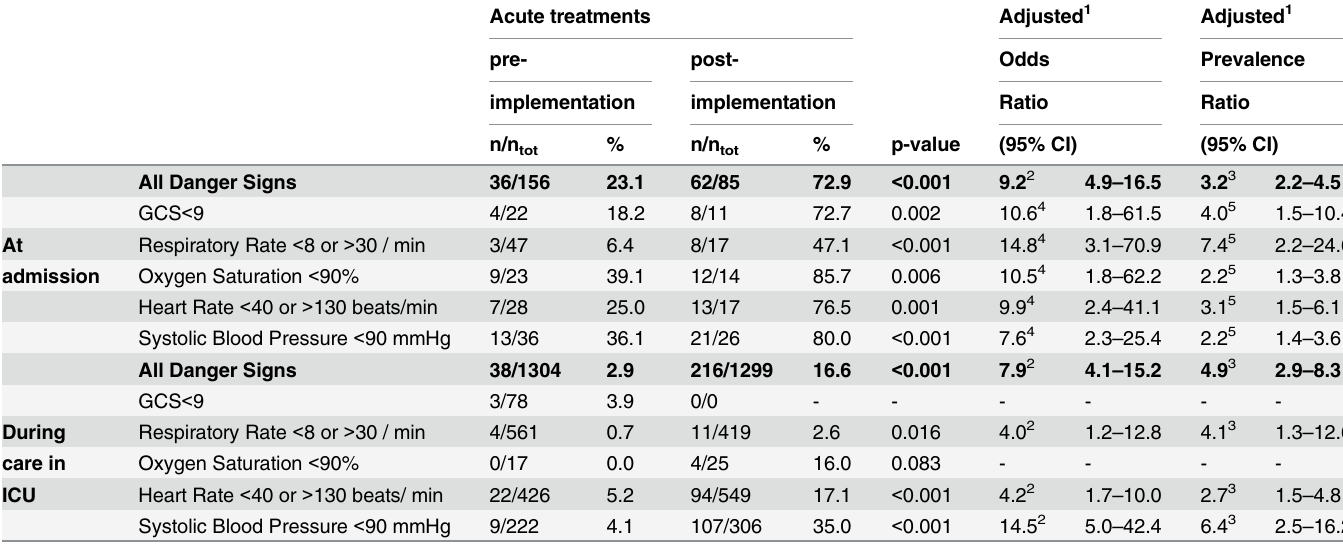
Table 2. Acute treatments. Acute treatments carried out when danger signs detected at admission to ICU and during care in ICU pre and post